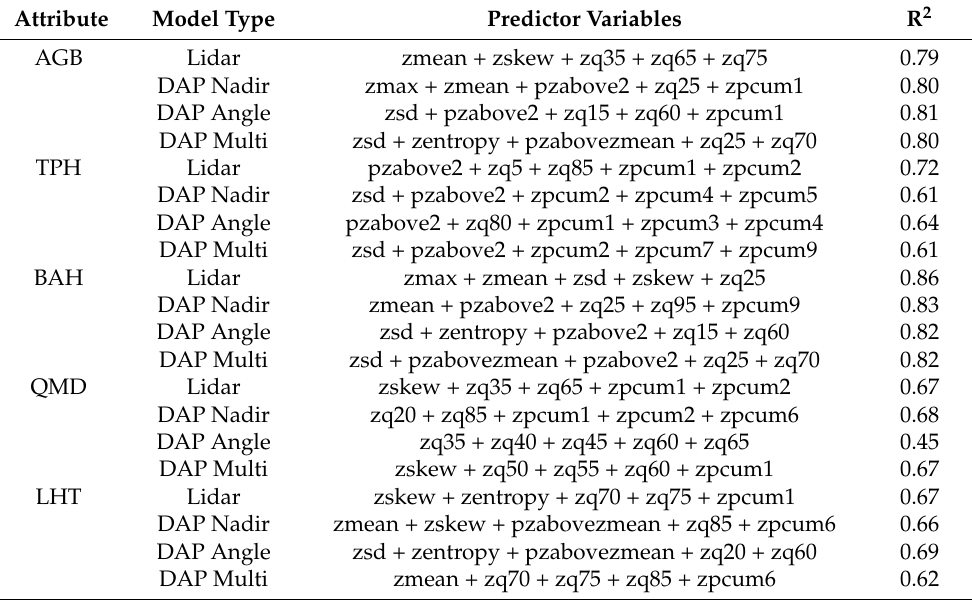
Table 3. Summary of plot-level regression models of forest attributes using lidar and DAP predictor variables. Attribute